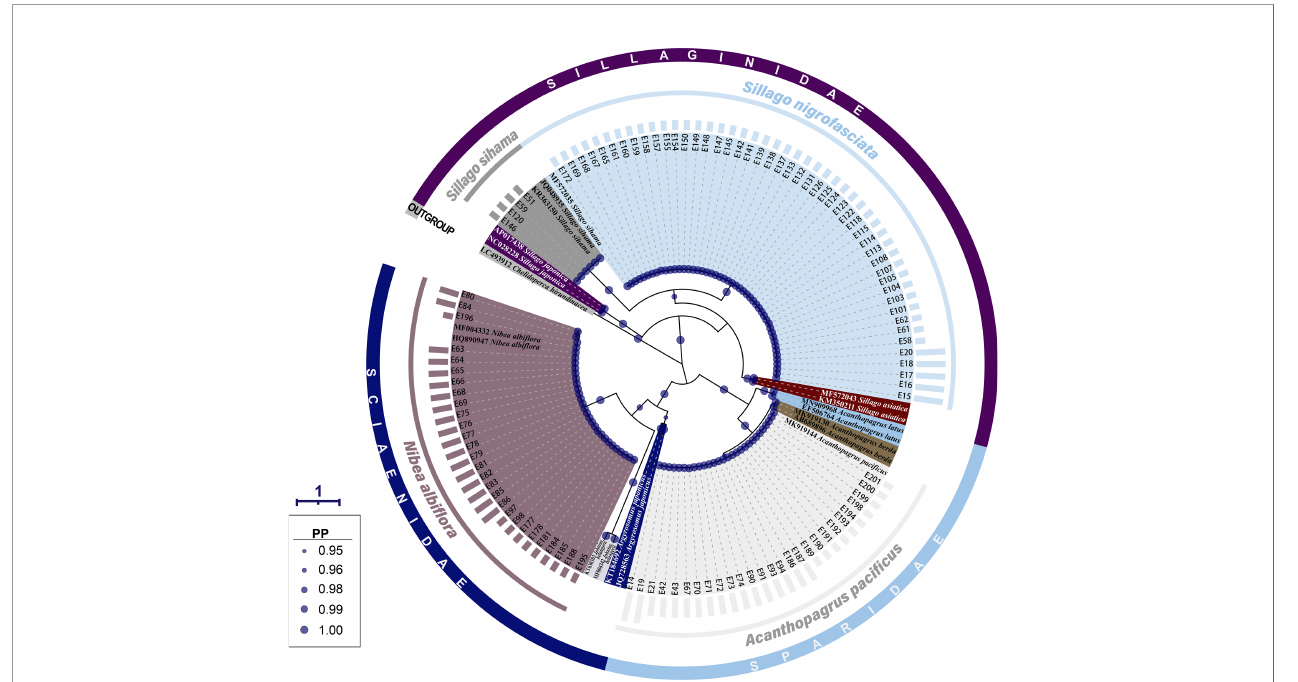
FIGURE 3 | A Bayesian inference (BI) tree based on 16S rRNA gene of 107 egg sequences combined with 19 sequences downloaded from the GenBank. The fi nal alignments of 574 positions were used to construct this BI tree. The column bars have three sizes (short, medium, long) and represent three developmental stages (early, middle, late) respectively. The scale bar indicates the average number of nucleotide substitutions per site. Values of posterior probability (PP) >=0.95 are shown in